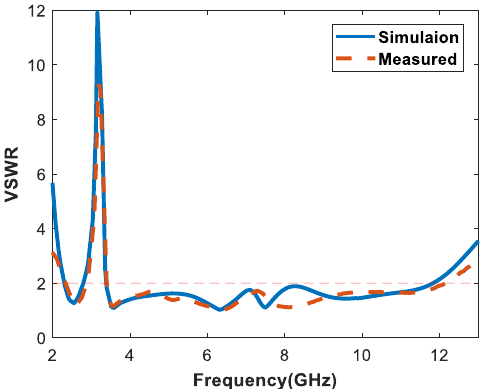
Figure 9. Comparison of the antenna VSWR between measurement and simulation.